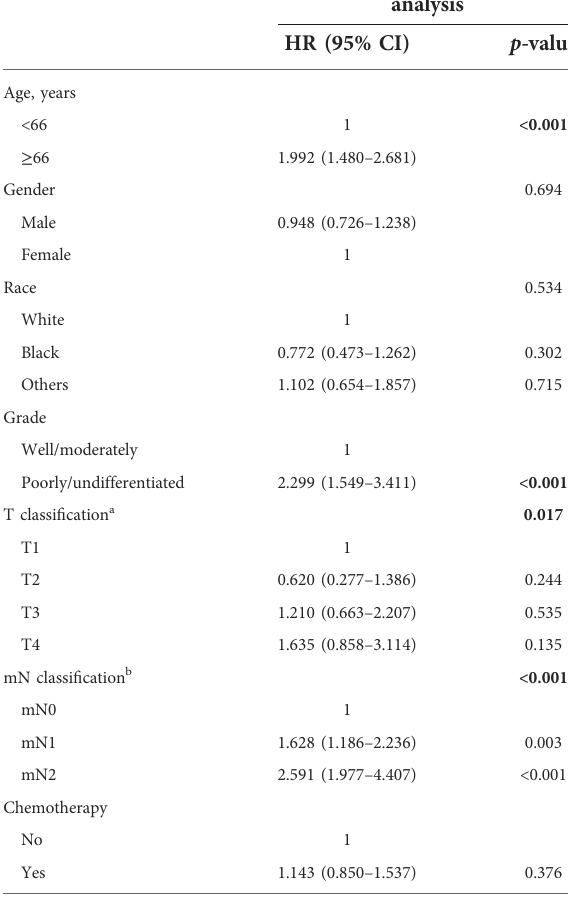
CSS, cancer-speci fi c survival; HR, hazard ratio; LNR, lymph node ratio; CI, con fi dence interval. p values less than 0.05 are marked as bold. a Staging based on current eighth AJCC system. b The mN status was based on LNR: LNR 0% (mN 0), LNR 0.01 – 0.60 (mN 1), and LNR >0.60 (mN